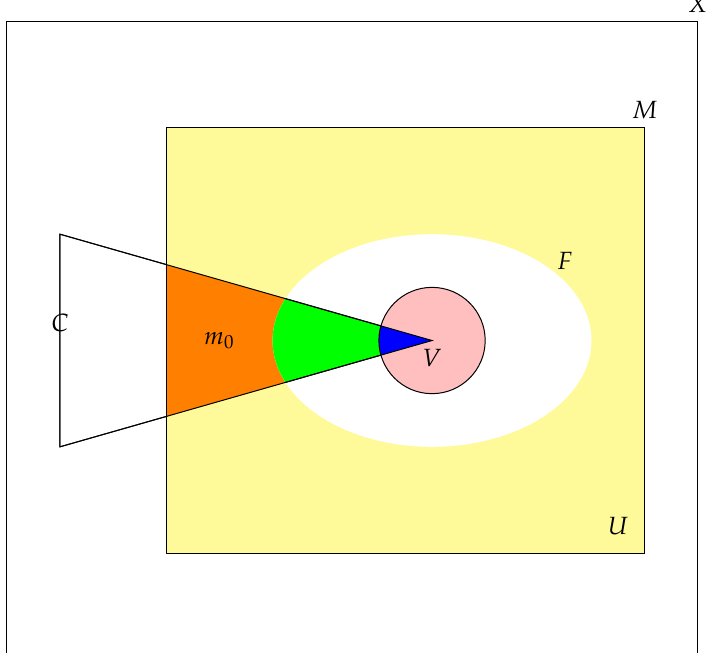
Figure 4. In yellow, elements in M with a unique (positive) price not in C . In orange, elements in C M Figure 4. Elements in M with a unique (positive) price not in C . Elements in C M with a unique ∩ ∩ with a unique (positive) price. In green, elements in C F with a unique (negative or null) price. In blue, (positive) price. Elements in C F with a unique (negative or null) price. Elements in C F with infinite ∩ ∩ ∩ elements in C F with infinite prices. In pink, elements in F with infinite prices not in C . In white, prices. Elements in F with infinite prices not in C . In white, elements in F with a unique (negative or null) ∩ elements in F with a unique (negative or null) price. Source: Own price. Source: Own elaboration.